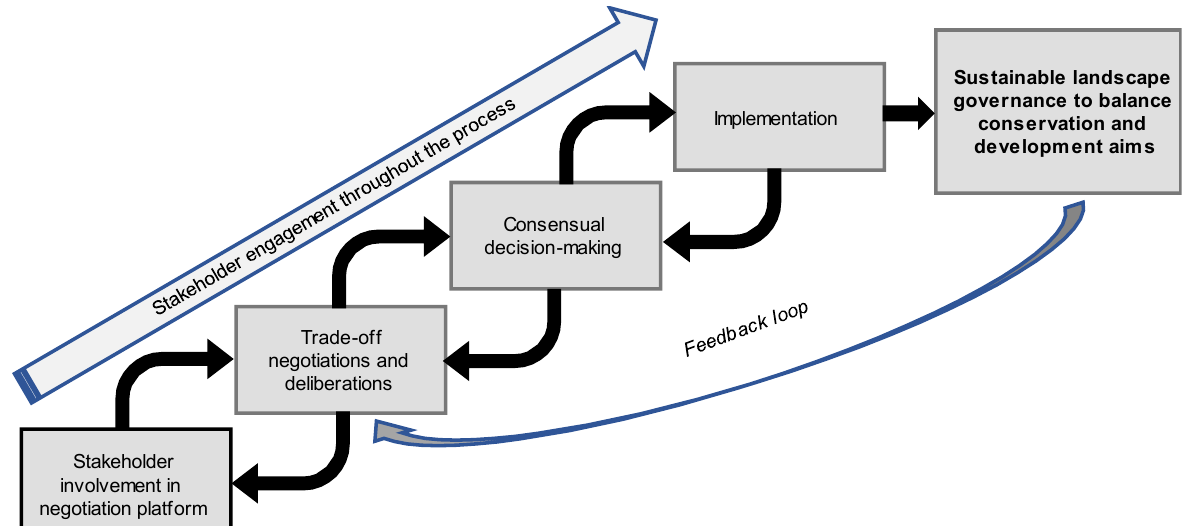
Figure 3. An iterative and adaptive conservation-development reconciliation process for sustainable landscape governance (Source: Authors).